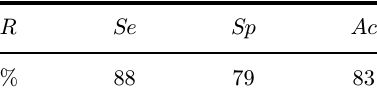
Table 4. Operational characteristics of the technique of polarization-variable laser auto°uorescence of cytological smears of mucous coat of cervix uteri endometrium of Group 1 (dysplasia) and Group 2 (cervical microinvasive